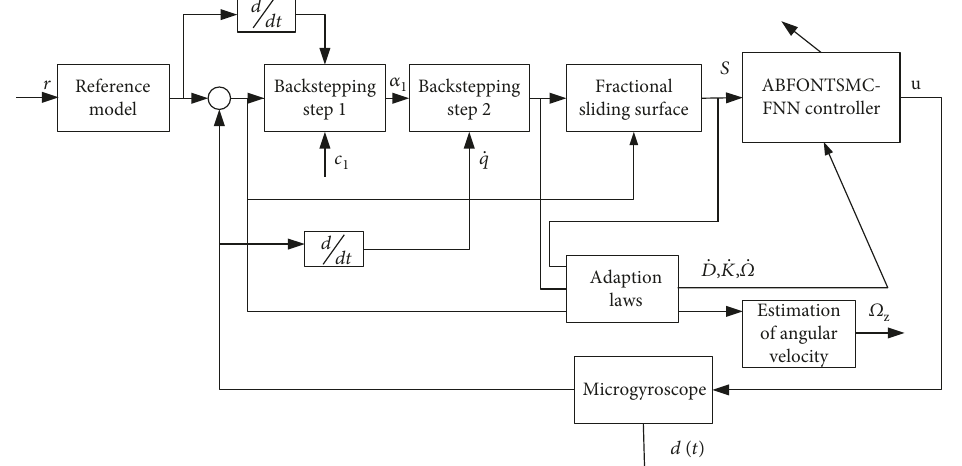
Figure 3: Block diagram of the ABFONTSMC-FNN